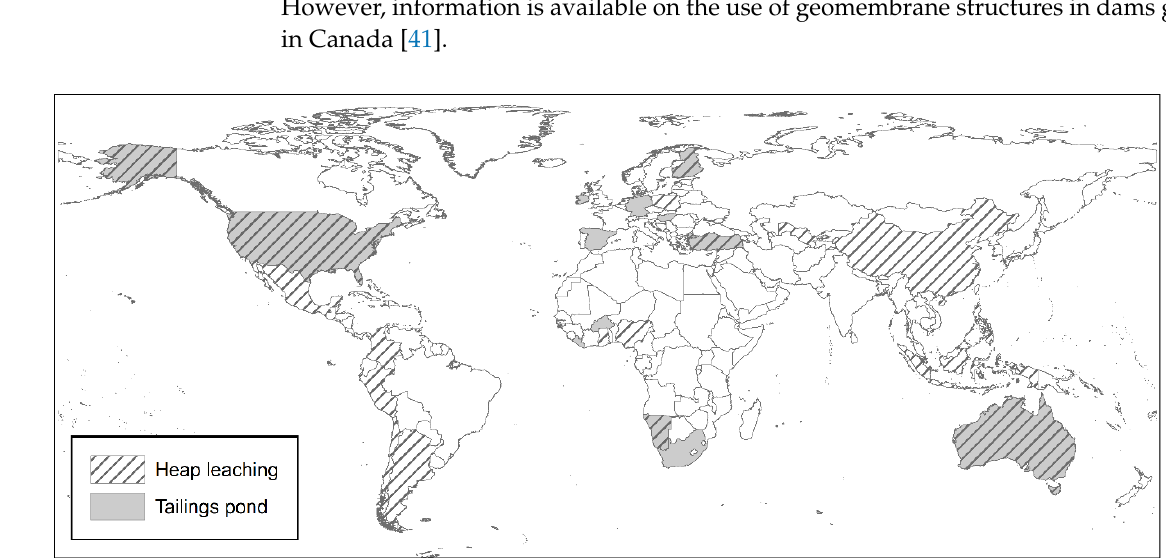
Figure 3. World map depicting current use of geomembranes in heap leaching and in the basal structures of tailings ponds around the world, as estimated from scientific publications and conference presentations.